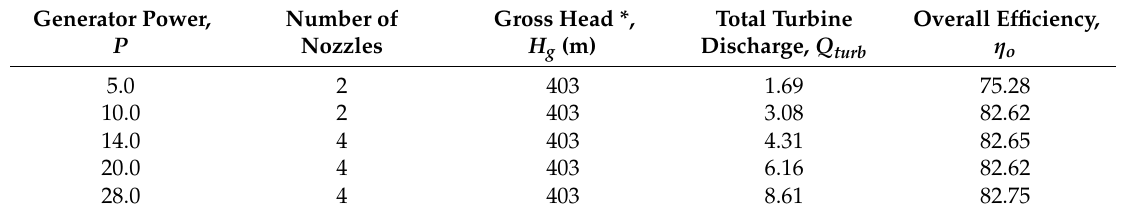
Table 2. Turbine Discharge Flow Derived from Generator Power.